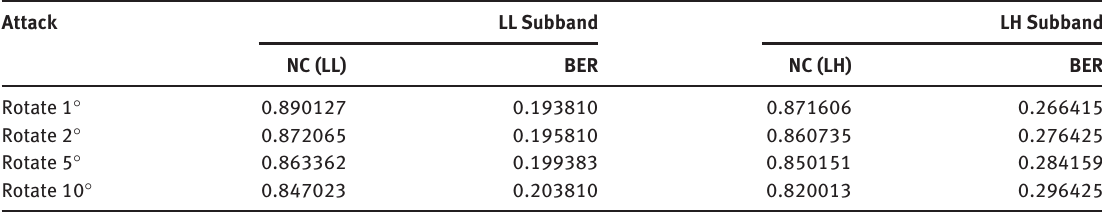
Table 5: Robustness against Rotation Attacks.